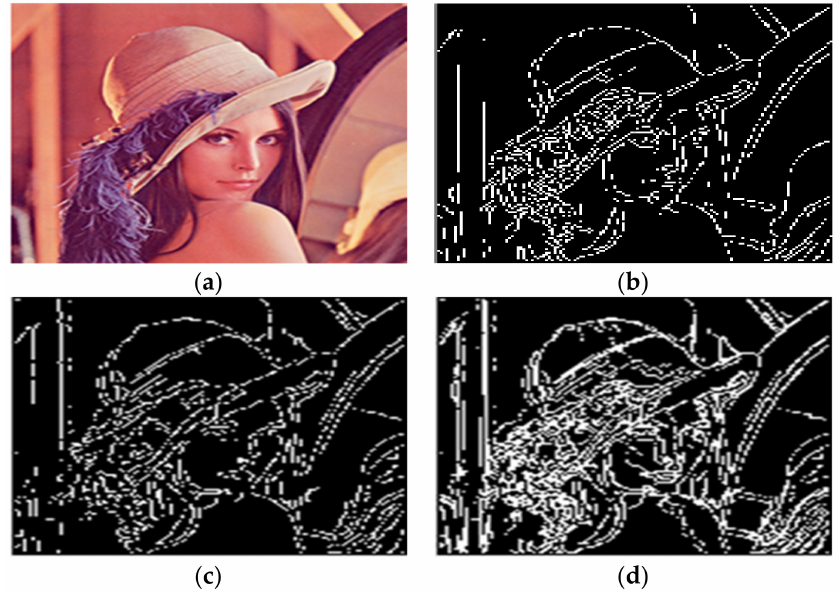
Figure 12. Segmentation results of LENA by different algorithms. ( a ) The original image. ( b ) The water division lines were obtained by the algorithm in this paper. ( c ) The water division lines were obtained by the algorithm in [11]. ( d ) The water division lines were obtained by the algorithm in